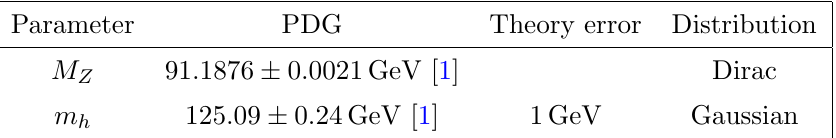
Table 1. Likelihoods in our analysis for the Higgs and Z -boson masses. We added in quadrature a 1 GeV theory error upon the SOFTSUSY calculation of m h